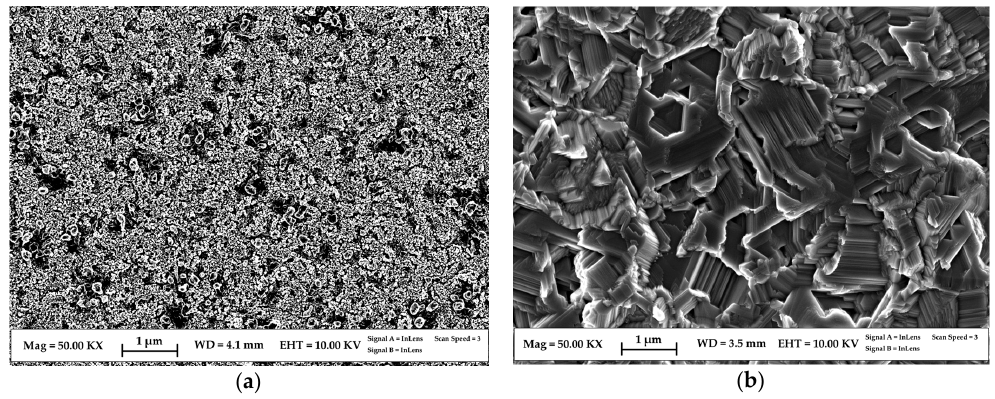
Figure 2. SEM image of the: ( a ) morphology of the as ‐ deposited In 2 Se 3 –Ga 2 Se 3 –Cu precursor sequence; and ( b ) the resulting Cu(In,Ga)Se 2 (CIGS) layer after selenization.